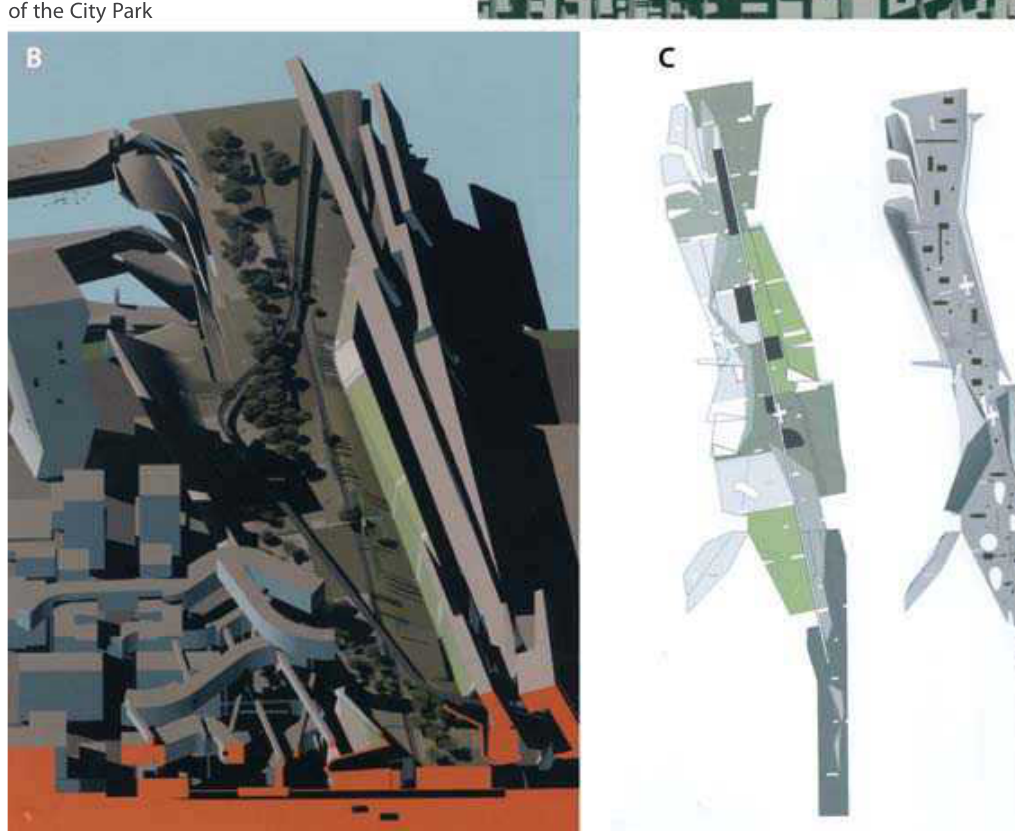
Fig. 2. Pro po sal for the com pe ti tion of the Ci ty Park de ve lop ment on Man hat tan’s Up per West Si de (Mayne 2004): A – mi xed-use in teg ra ted const ruc tion of uni ta ry fab ric of ur ban morp- host ruc tu re; b – ove rall view of the com plex (mo del); C – Chan nels of the rec re a tio nal links of the Ci ty